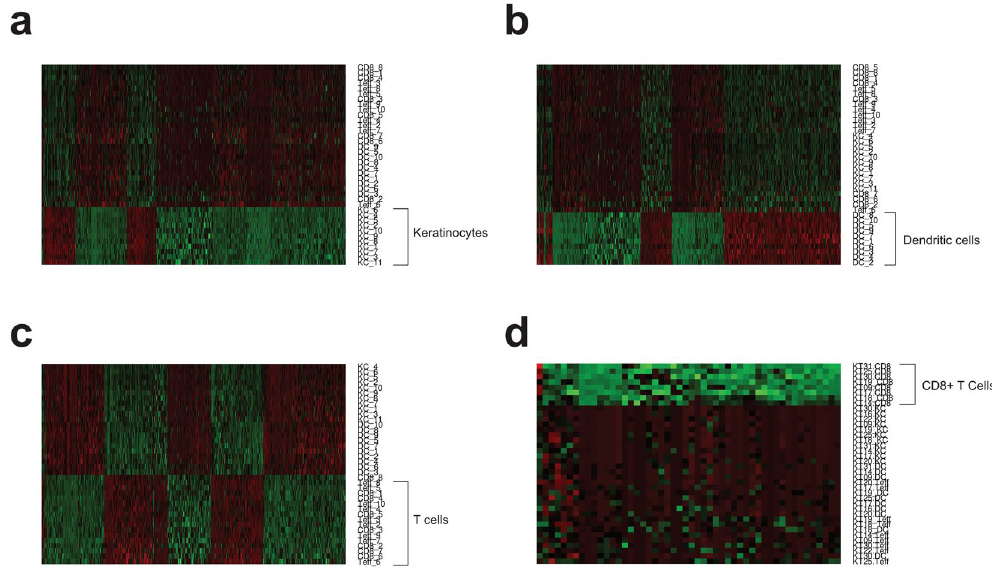
Figure 6. Gene expression heatmapping of module genes reveals cell type-specific patterns of expression. Gene expression heatmap of all module genes for the keratinocyte associated module ( a ), the dendritic cell associated module ( b ), the T cell associated module ( c ), and the CD8 + T cell associated module ( d ).